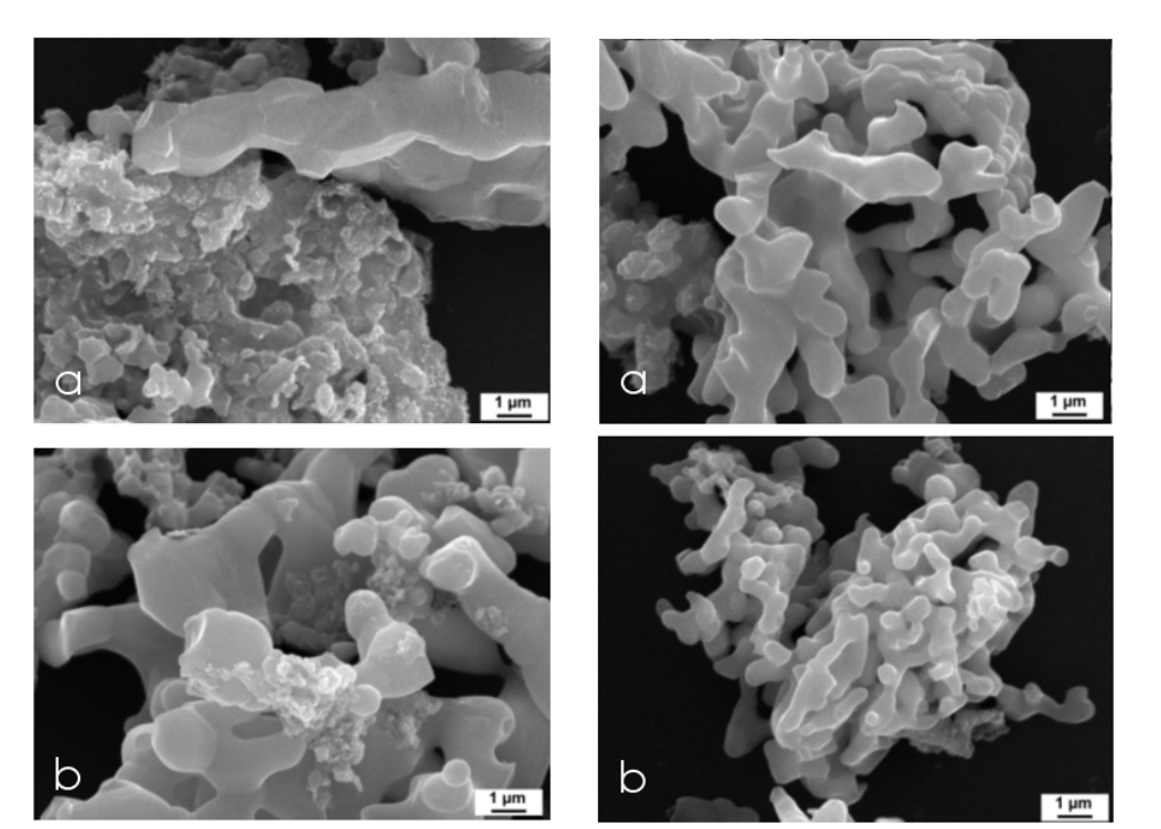
Figure 8. SEM micrographs of HA samples synthesized at 1000 o C from the sol prepared at (a) pH ~11.0 and (b) pH ~12.0. Magnification